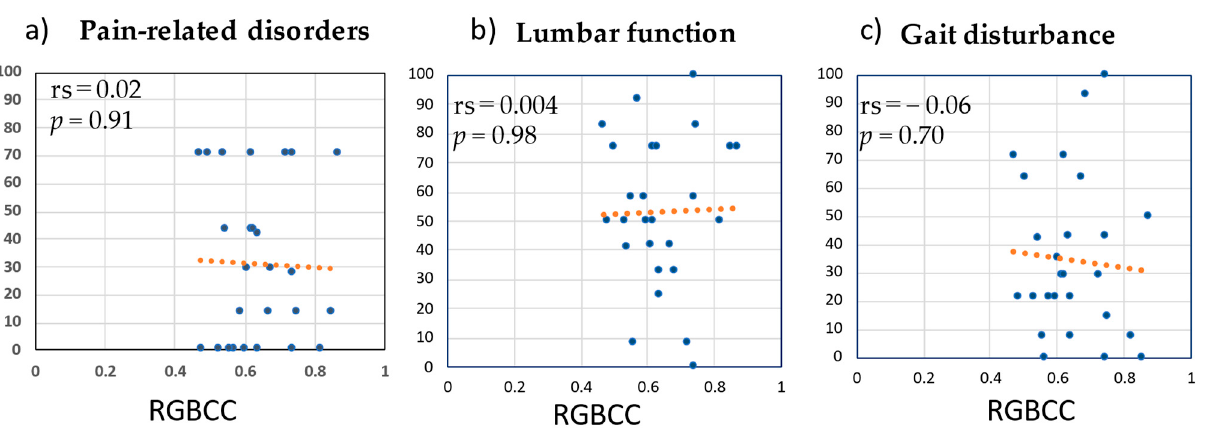
Figure 7. Correlations of red, green, and blue correlation coefficient (RGBCC) with scores of the domains of Japanese Orthopedic Association Back Pain Evaluation Questionnaire. ( a ) RGBCC ver- sus score of pain-related disorders, ( b ) RGBCC versus score of lumbar function, ( c ) RGBCC versus score of gait disturbance, ( d ) RGBCC versus score of social life disorders, ( e ) RGBCC versus score of mental disorders. 3.6. Correlation between RGBCC and PCS Score in the LBP Group Figure 8 shows the correlation of RGBCC with the score of each subscale of PCS and with the total PCS score. The total PCS score did not correlate with RGBCC (rs = 0.24, p = 0.24). Regarding the subscales, rumination had a significant correlation with RGBCC (rs = 0.40, p = 0.04), while helplessness and magnification did not correlate with RGBCC (rs = 0.021, p = 0.94 and rs = 0.04, p = 0.41, respectively).